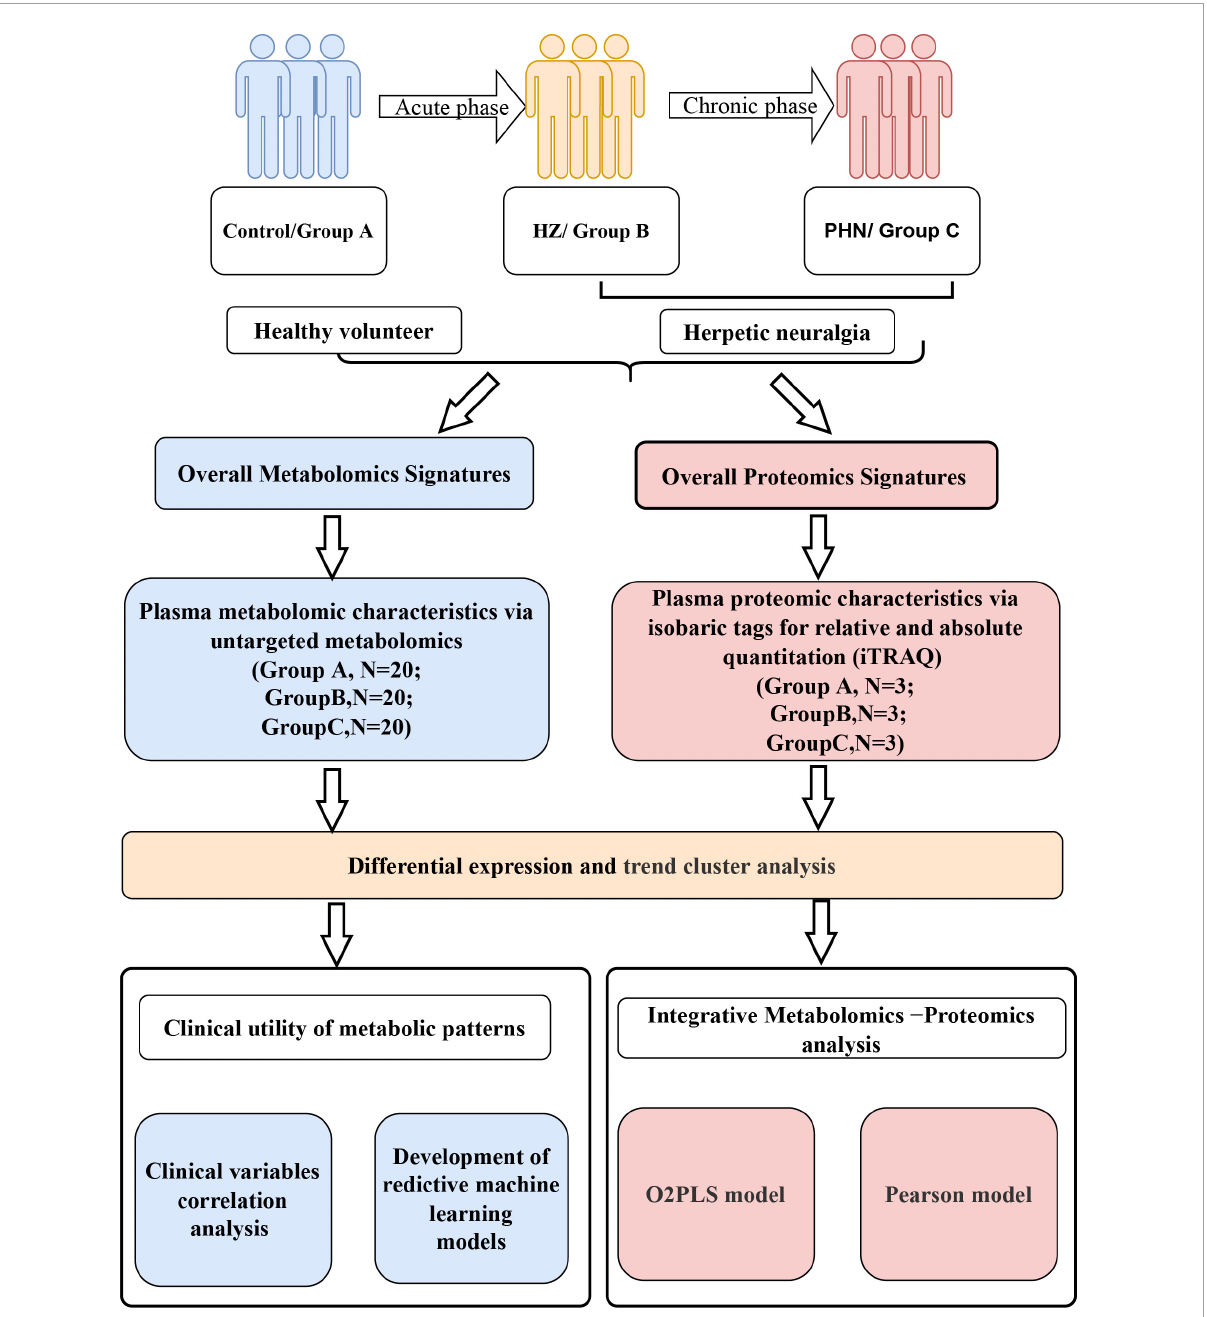
FIGURE1 Flowchart depicting metabolomic and proteomic characteristics of herpes zoster and postherpetic neuralgia.